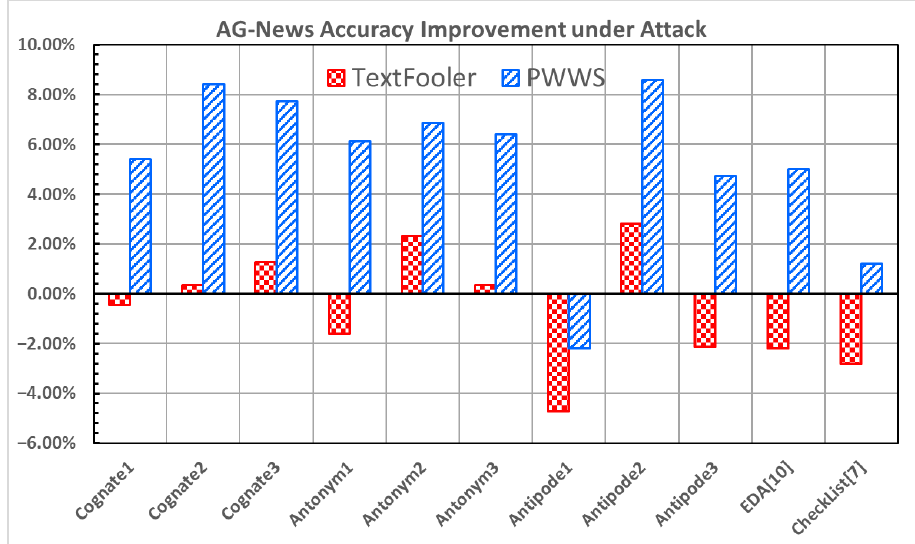
Figure 5. AG-News Accuracy Improvement Under Attack.